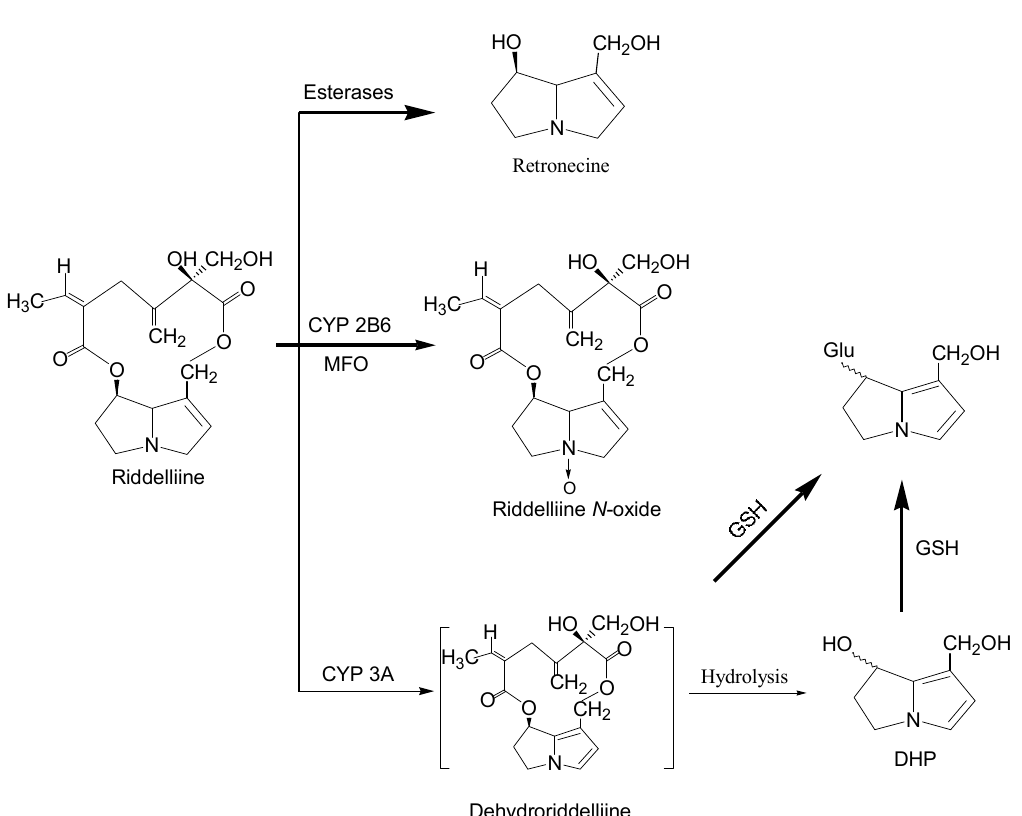
Figure 7. Invention of pyrrolizidine alkaloid induced carcinogenesis by enzyme